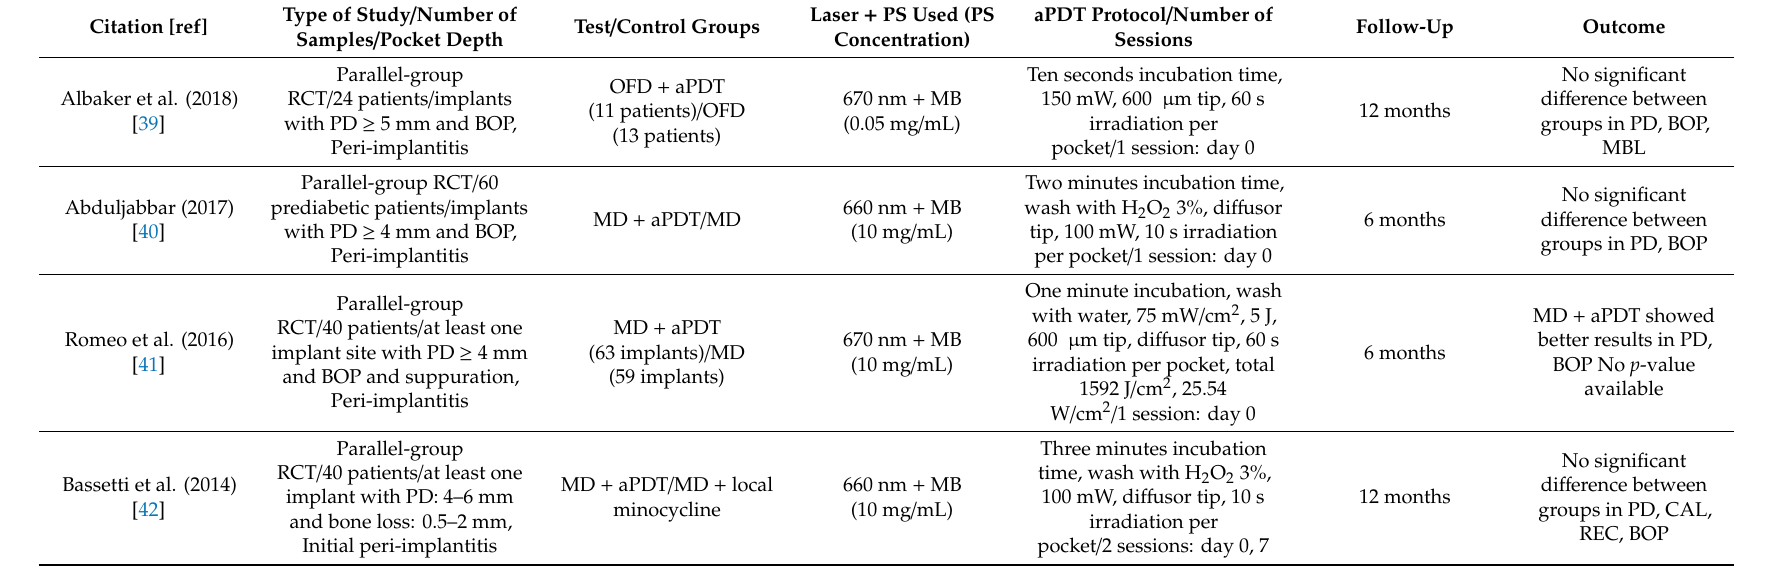
Table 2. Studies of aPDT in